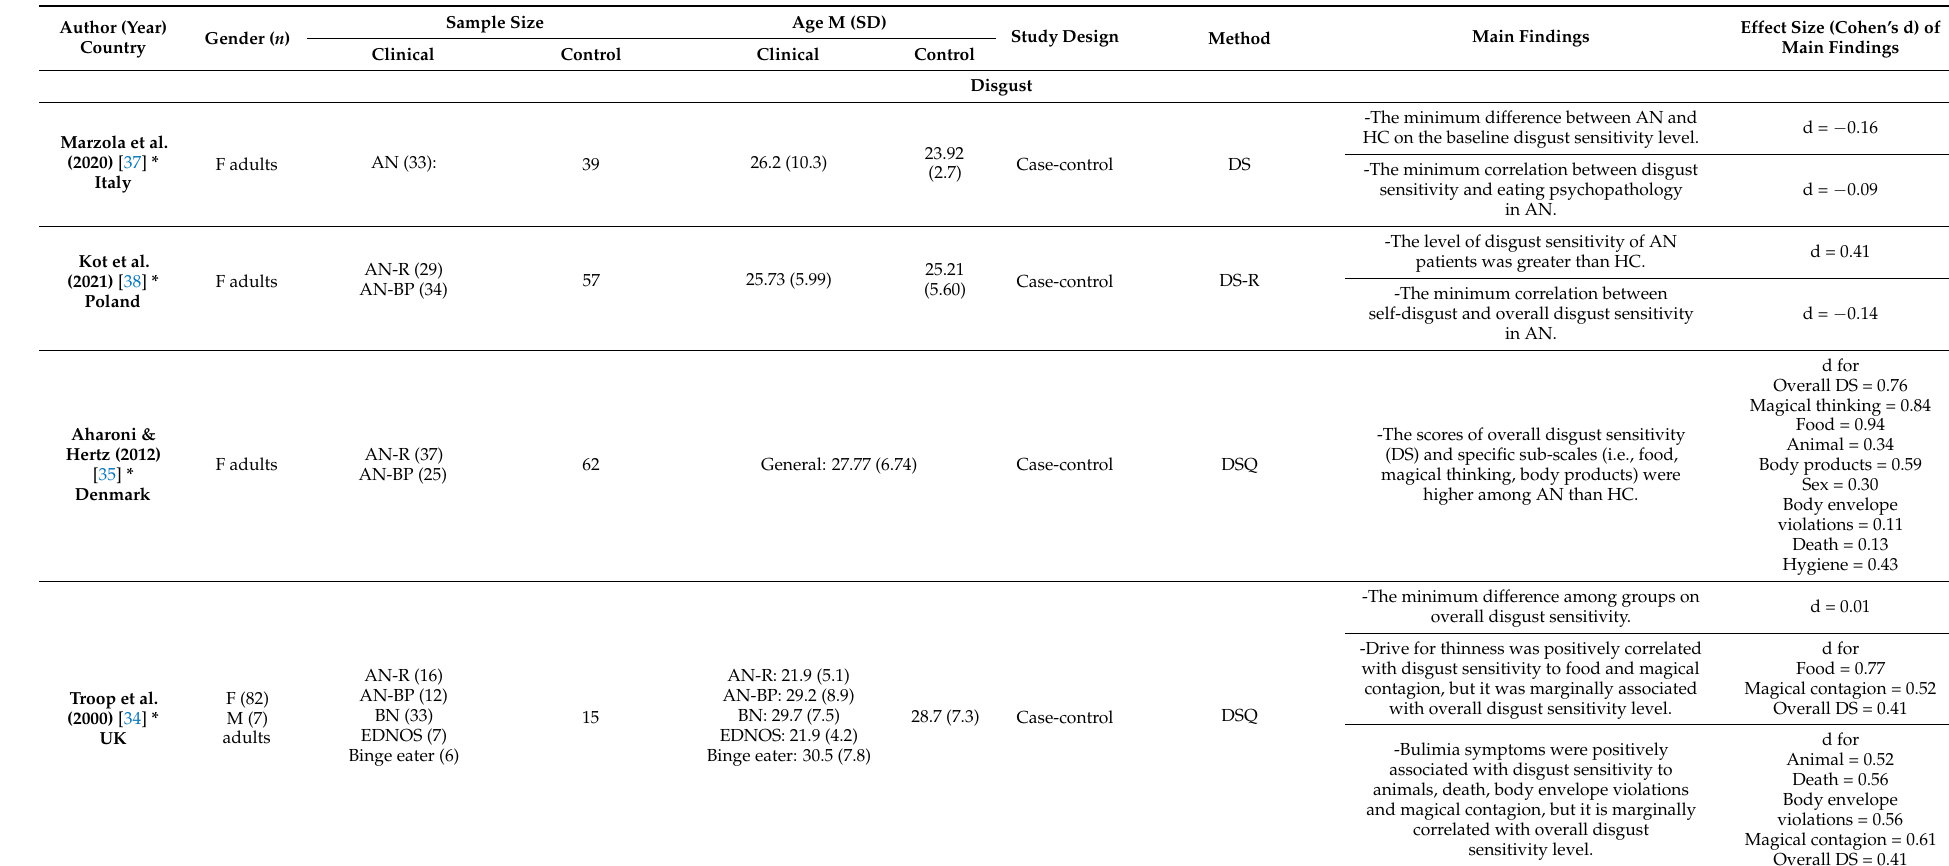
Table 1. A summary of studies using questionnaires to examine disgust and